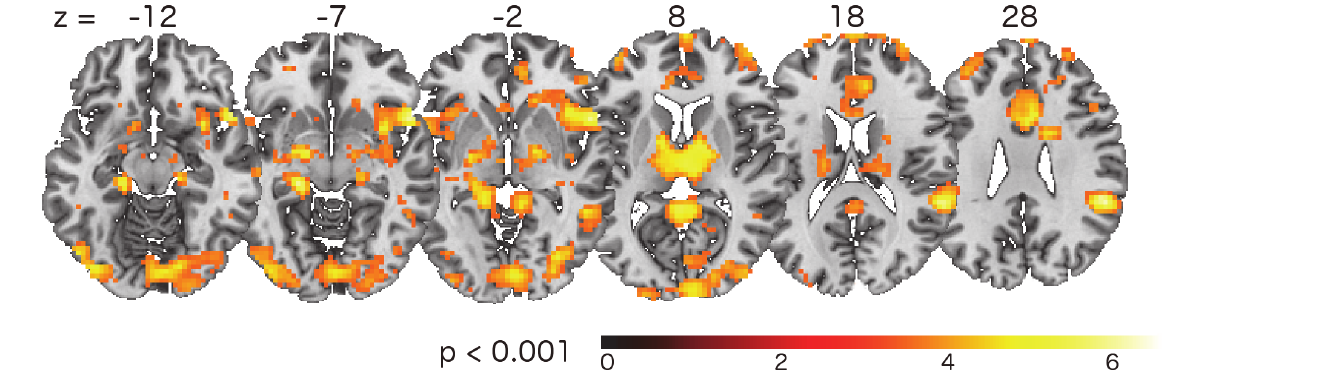
Fig 7. Main effect of adaptation. Low-Compliant ’ t-map results for the second level analysis of ‘ adapted-non > adapted ’